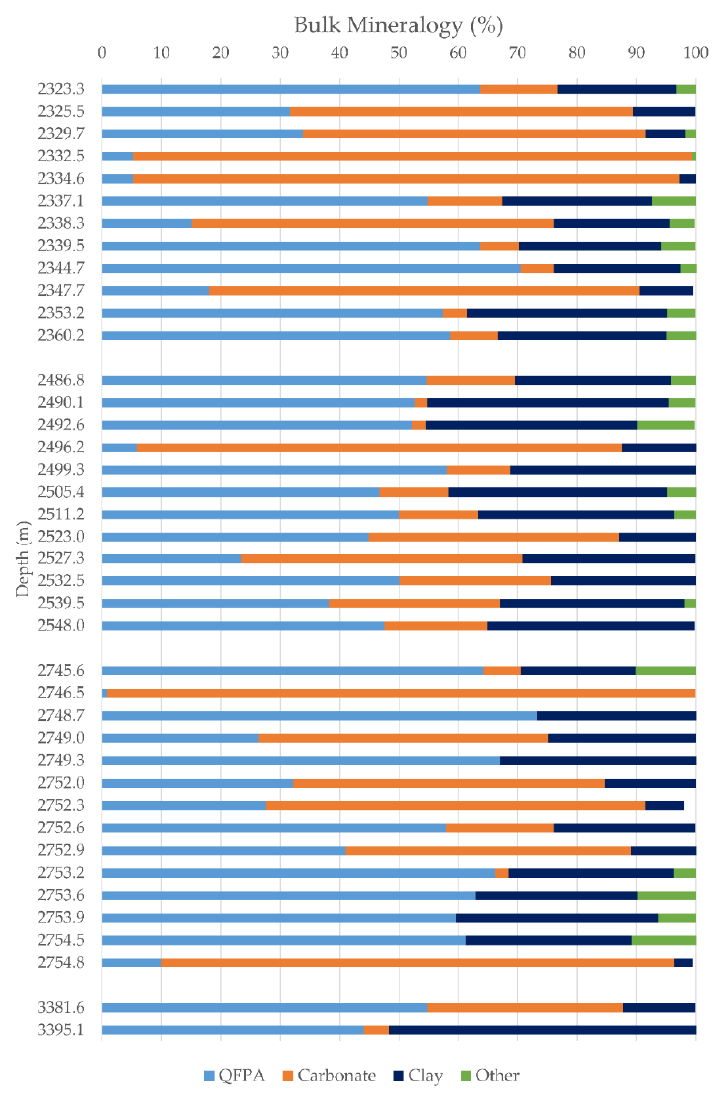
Figure 6. RIR quantifications of representative whole rock samples from the study interval. Phases were combined into four major groups. QFPA = quartz, feldspars, pyrite, apatite; carbonates = calcite and dolomite; clay = mica and clinochlore; other = remaining minor phases, see Appendix A.